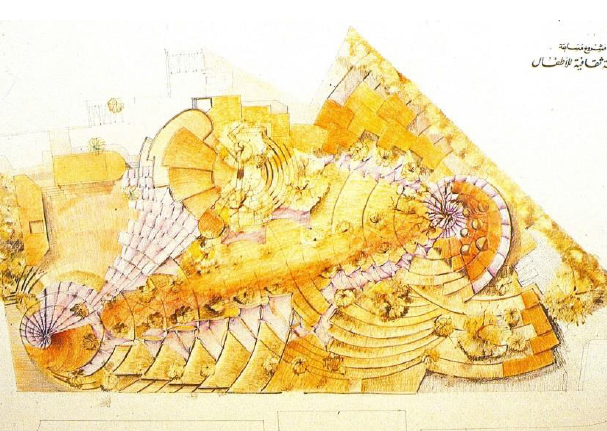
Figure 4 : Park Design Entry in the Competition, Ibrahim,